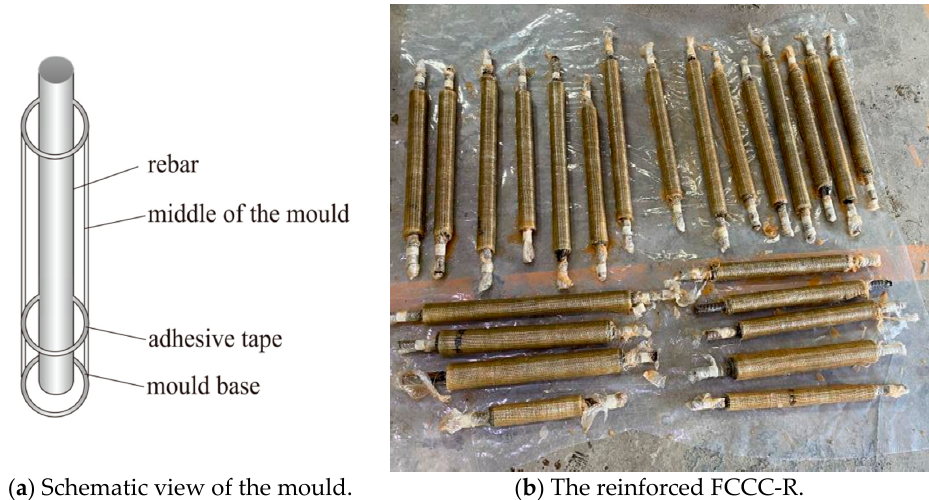
Figure 2. Schematic view of the mould and reinforced FCCC-R